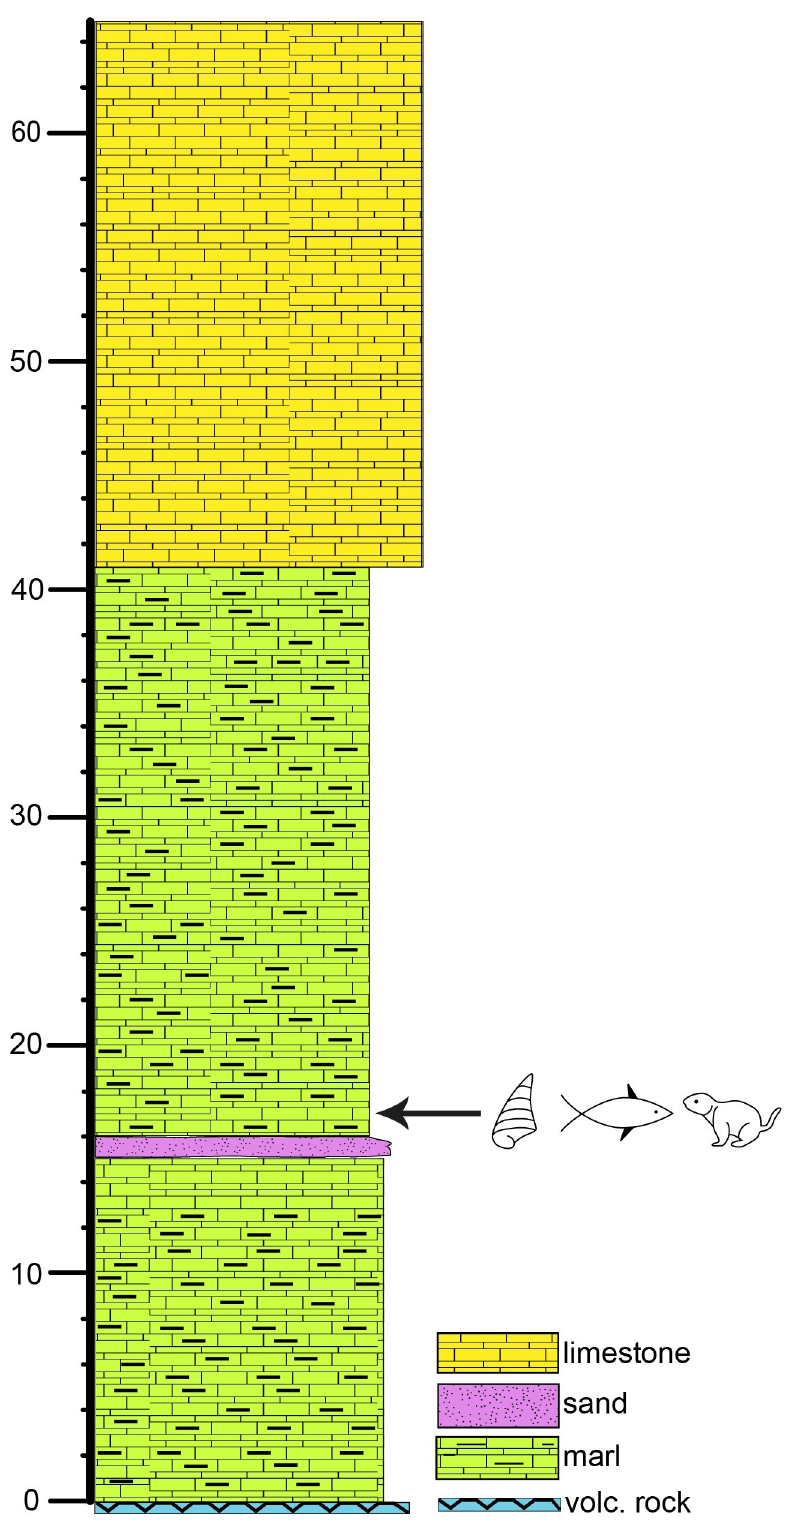
Fig 4. Sedimentary succession of the I ş ι klar Formation at the fossil site. C¸evirme (Erzurum Province, Tekman district) according to Sickenberg (1975).